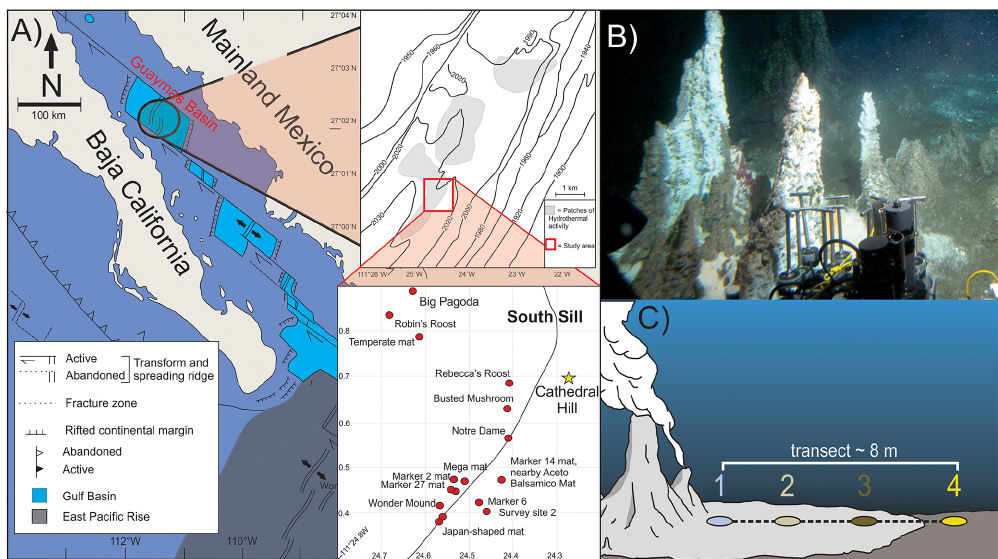
Figure 1. (a) Location map of Guaymas Basin and the southern sill (red outlined box) in the Gulf of California. Cathedral Hill is marked with a yellow star. (b) Photo of Cathedral Hill taken via HOV Alvin . (c) Schematic of the push-core transect with a color coding that is consistent for all plots throughout this paper. Maps modified from Teske et al. (2016), Dalzell et al. (2021), and Bentley et al.